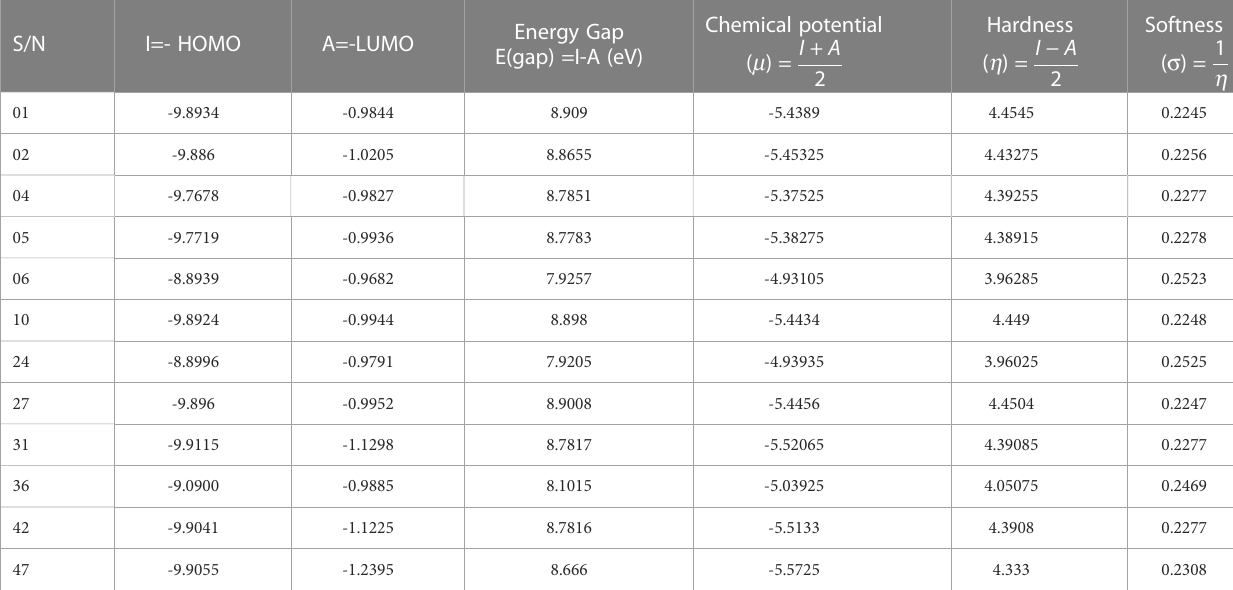
TABLE 4 Data of chemical descriptors